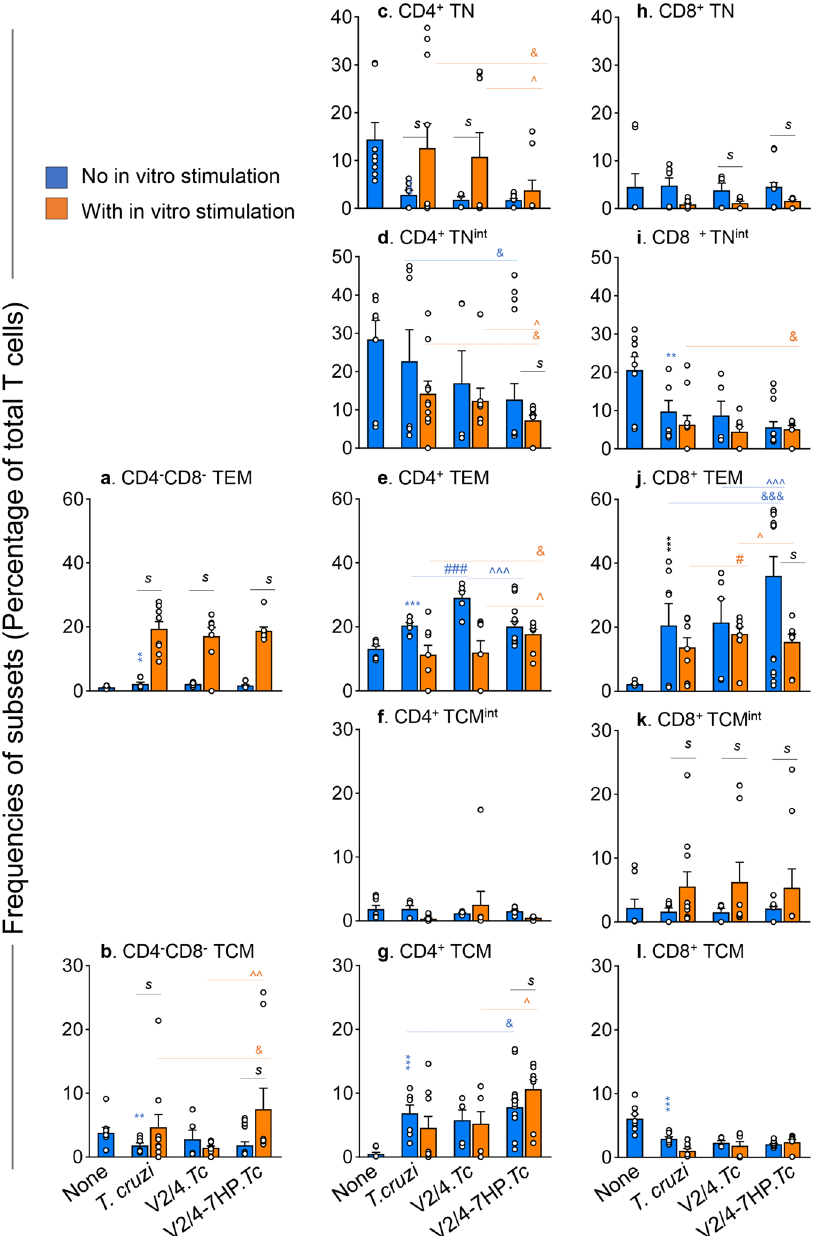
Fig. 3 Effects of 7HP349 adjuvant on vaccine-induced T cells phenotype in T. cruzi infection. C57BL/6 female mice were prophylactically immunized with V2/4 in the presence or absence of 7H349, challenged with T. cruzi , and euthanized at 21 days post-infection as is described in Fig.2c. Splenocytes were either used immediately (blue bars) or incubated for 48 h with T. cruzi antigenic lysate (orange bars). Cells were labeled with fl uorescent-conjugated antibodies and analyzed by fl ow cytometry. Self-organizing meta-clusters of CD3 + T cells based on the expression levels of CD4, CD8, CD62L, and CD44 antigens were formed by FlowSOM analysis. The bar graph shows percent positive of CD4 − CD8 − ( a , b ), CD4 + ( c – g ), and CD8 + ( h – l ) T cell subsets that exhibited naïve (TN, c , h ), naïve intermediate (TN int , d , i ), effector/effector memory (TEM, a , e , j ), central memory intermediate (TCM int , f , k ) and central memory (TCM, b , g , i ) phenotype in no treatment/no infection, non-vaccinated/infected, V2/4. Tc and V2/4-7HP349. Tc groups of mice. Data are plotted as mean values ± SEM ( n = 5 – 10 mice per group). Signi fi cance between control vs. infected mice (*) was calculated by unpaired t -test or Mann-Whitney U test. Signi fi cance among infected groups was calculated by 1-way analysis of variance (ANOVA) with Tukey ’ s post-hoc test (comparison of multiple groups) and plotted as # infected vs. V2/4. Tc , ^infected vs. V2/4-7HP349. Tc , and & V2/4-7HP349 vs. V2/4. P values of <0.05, <0.01, and <0.001 are annotated with one, two, and three symbols, respectively. The horizontal bar indicates the compared groups. In some graphs, the horizontal bar with s indicates signi fi cance ( p < 0.05) between matched groups before and after in vitro